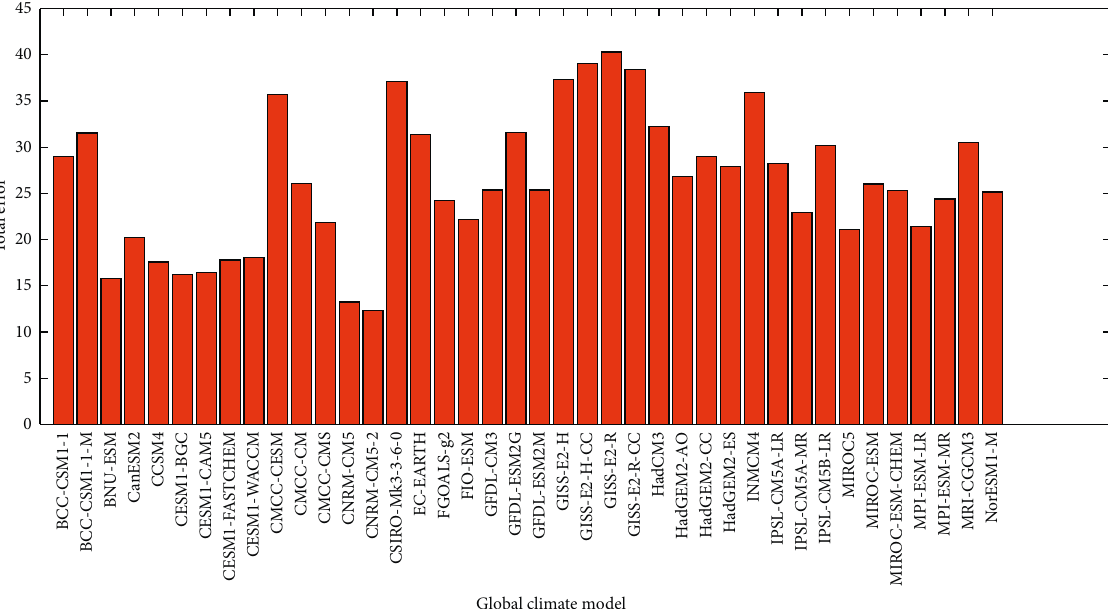
Figure 5: Total errors of 40